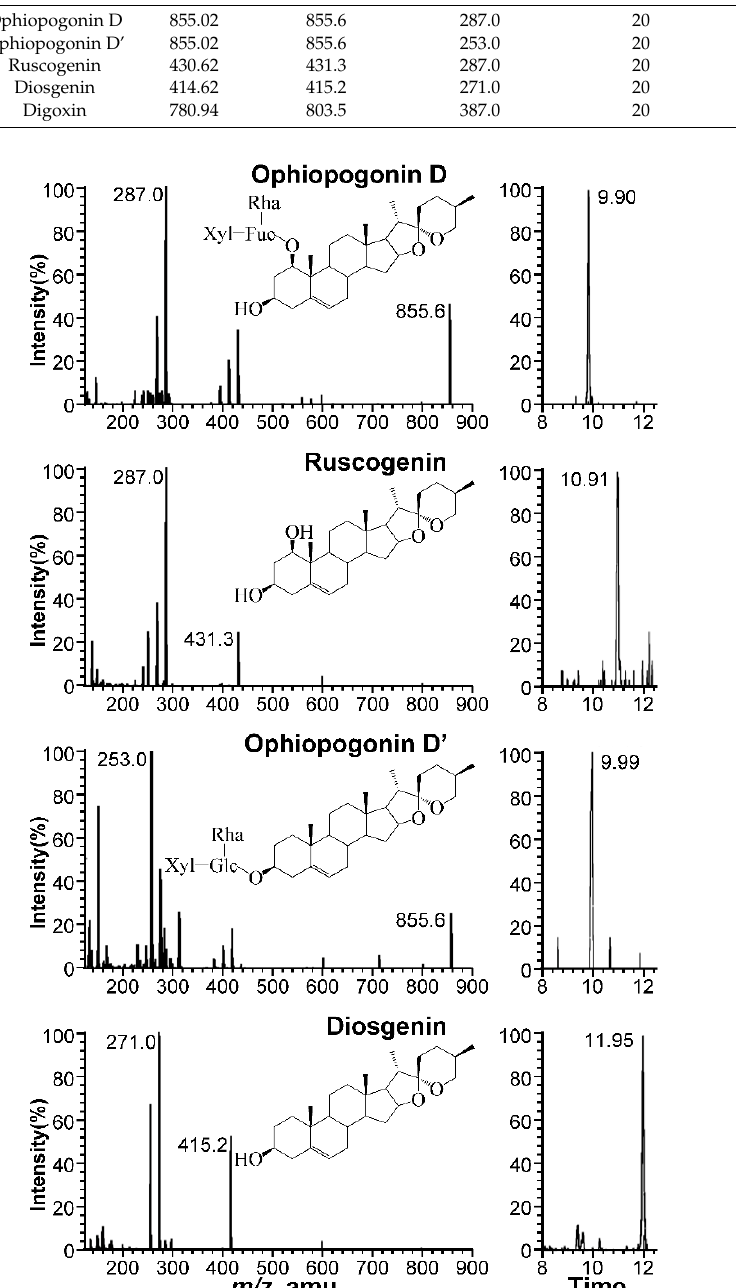
Table 1. Analytic parameters of ophiopogonins by UPLC-MS / MS in fermented broth of human gut microbiota.